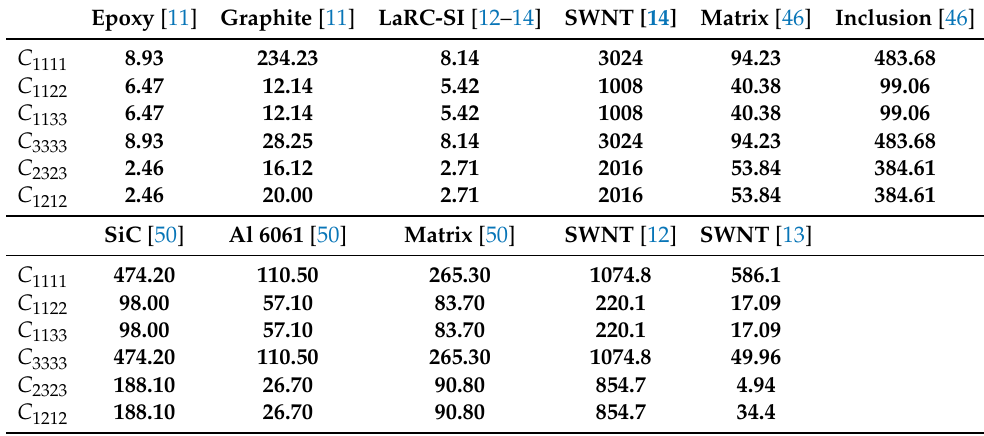
Table 2. Constituents’ elastic properties [ GPa ] . SWNT: single-walled